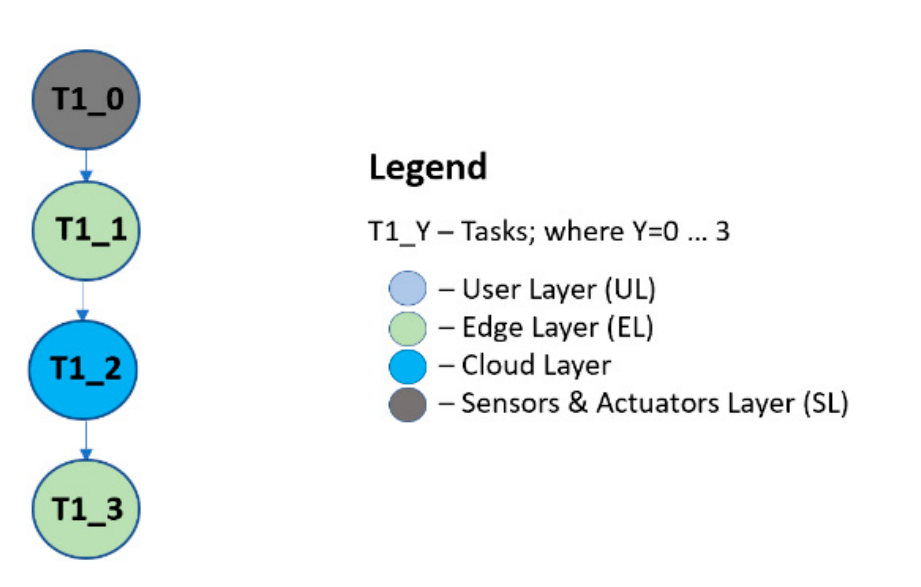
Figure 4. Task graph for the problem of monitoring/managing parking spaces.